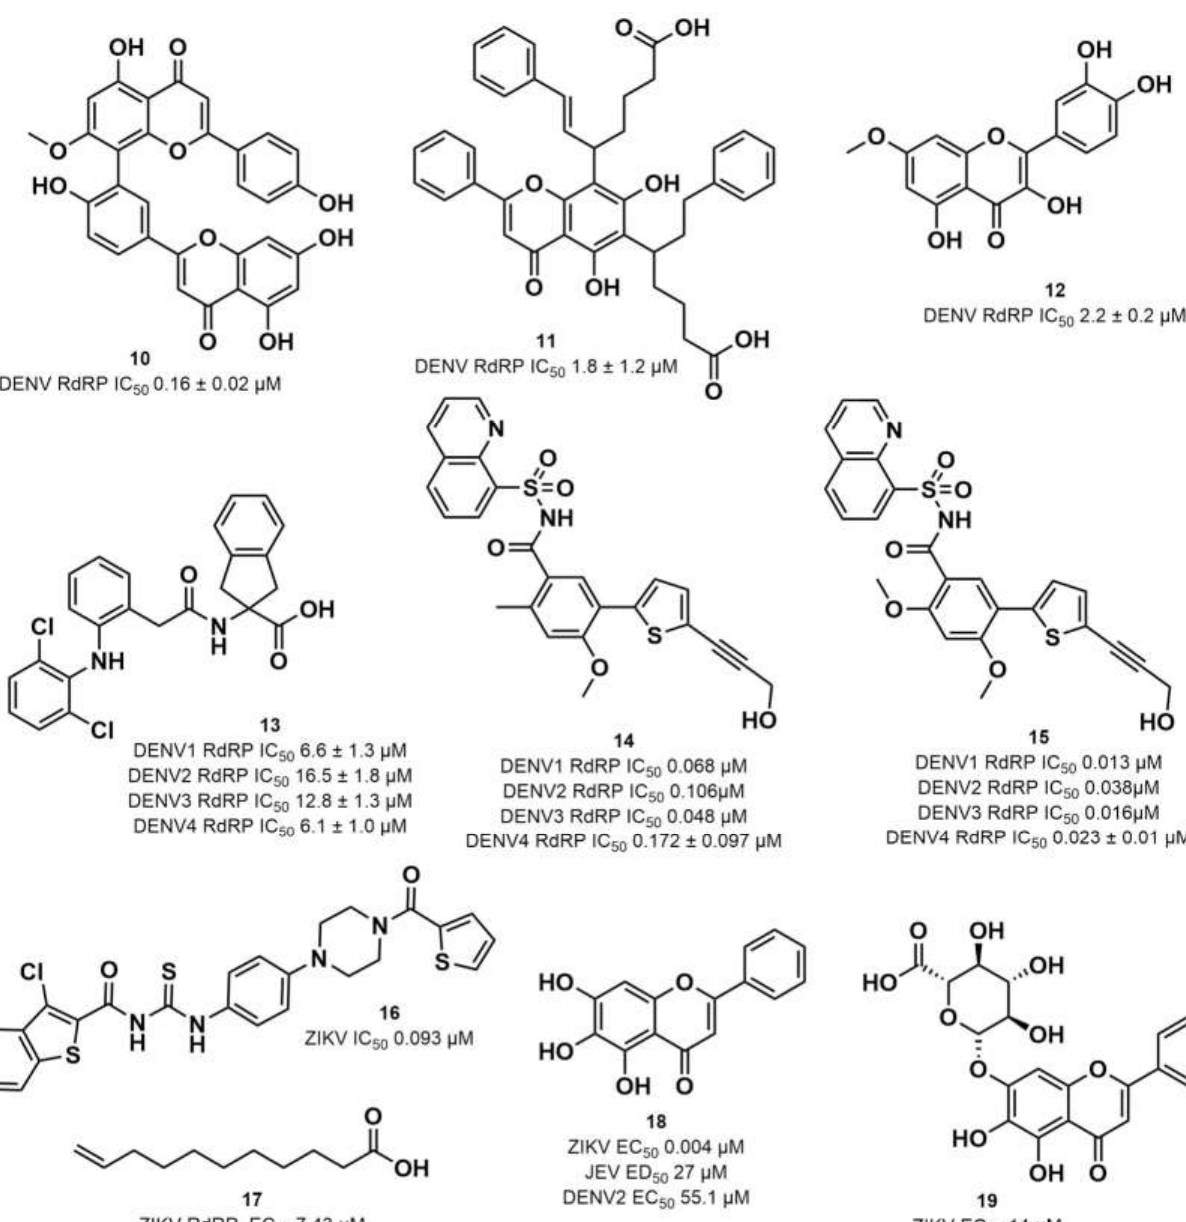
Figure 4. DENV and ZIKV RdRp known inhibitors and their respective IC 50 values at RdRp: ( 10 ) podocarpusflavone A [31]; ( 11 ) chartaceone D [21]; ( 12 ) rhamnetin [30]; ( 13 ) bis-chloro-